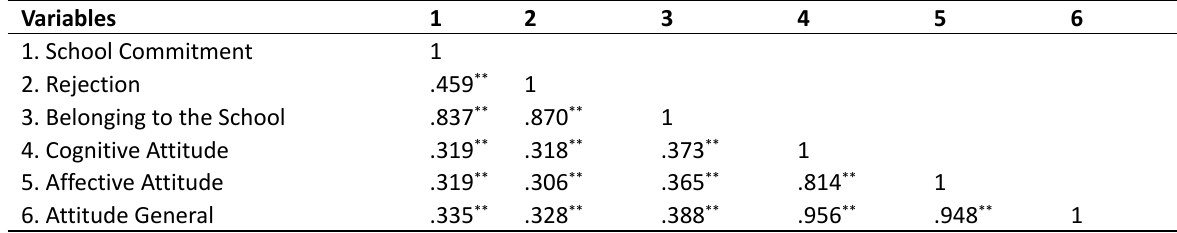
Table 2. Results of correlation analysis of attitude and school belonging dimensions to physical education course Variables